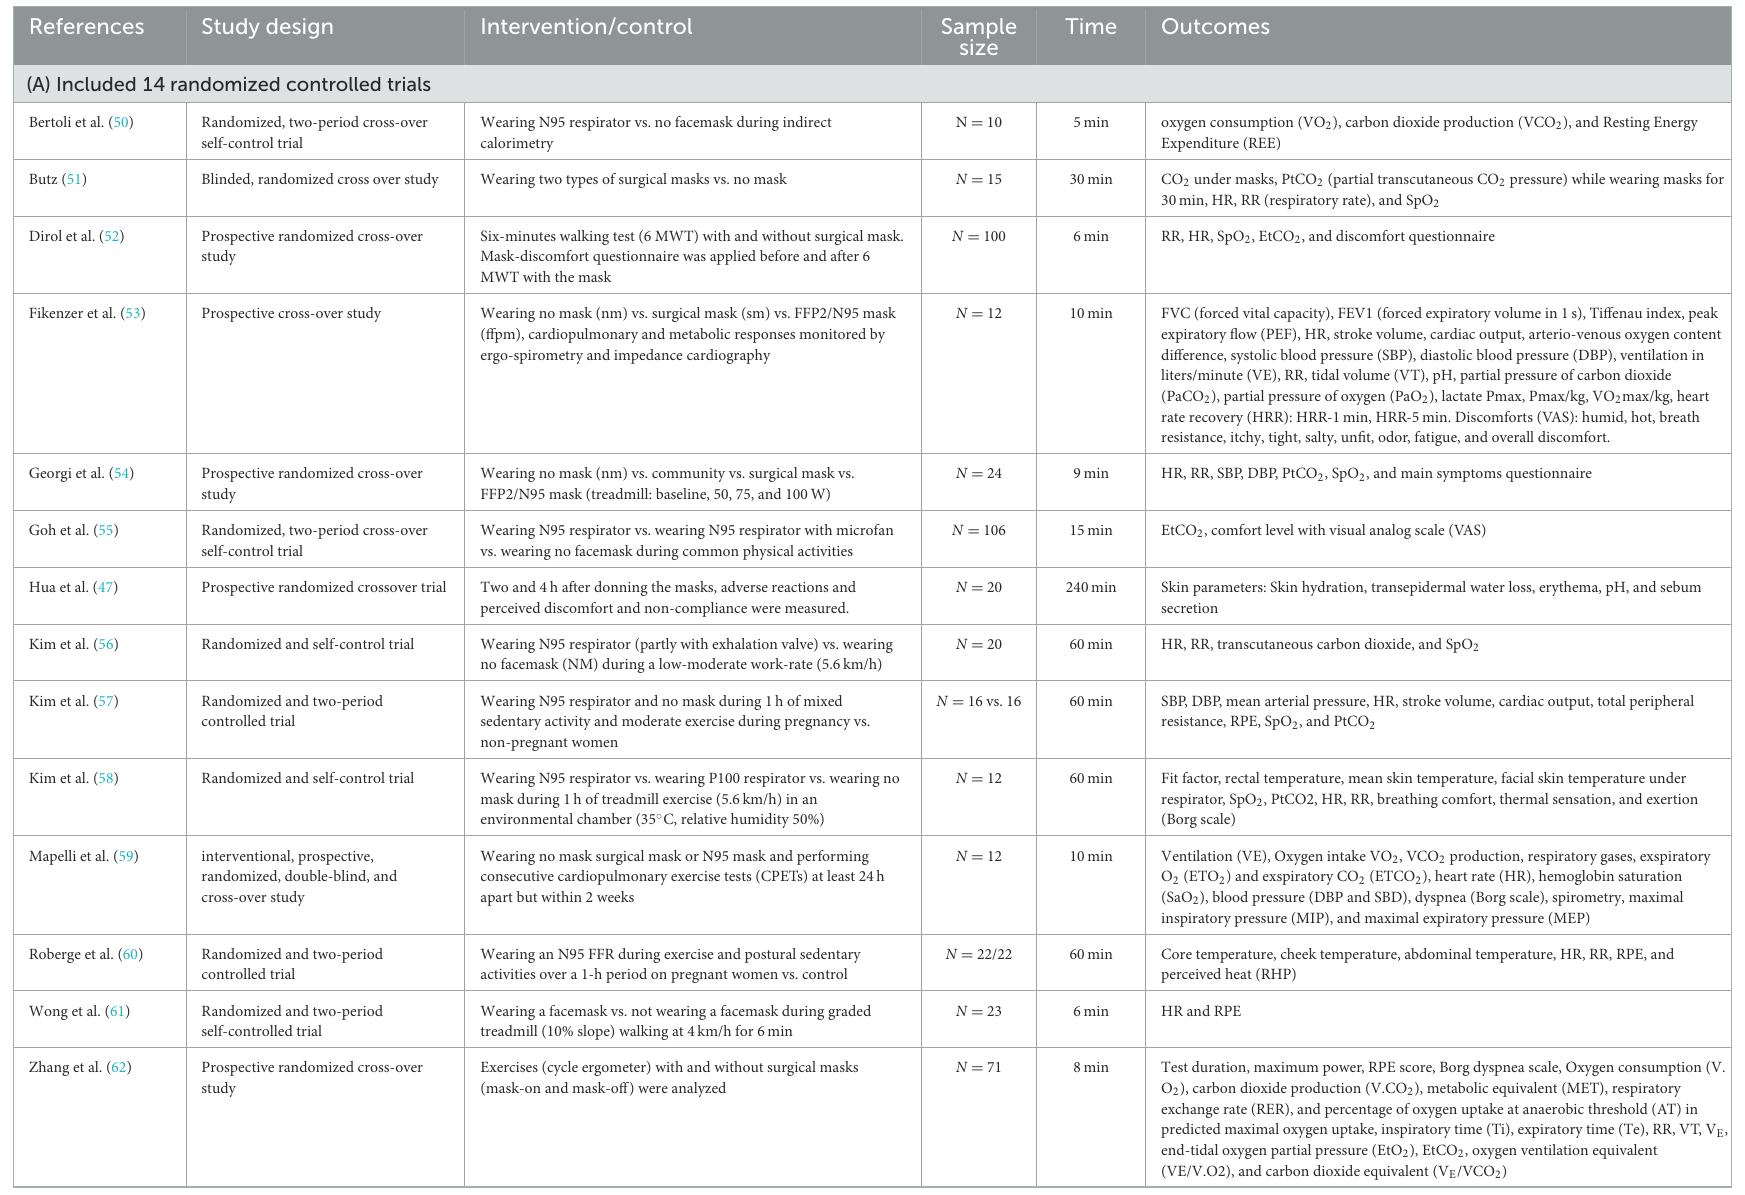
TABLE 1A (A–C) Overview of 54 included studies. (A) Randomized controlled trials, (B) non-randomized controlled trials, and (C) observational